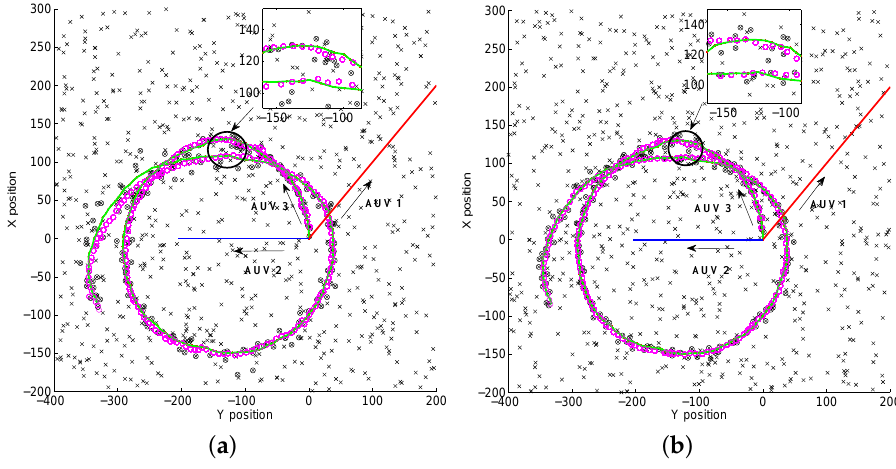
Figure 7. Trajectories, clutter, and measurements in Scenario 1. ( a ) Result with respect to AUV 1 only; ( b ) Result with respect to AUV 2 only.